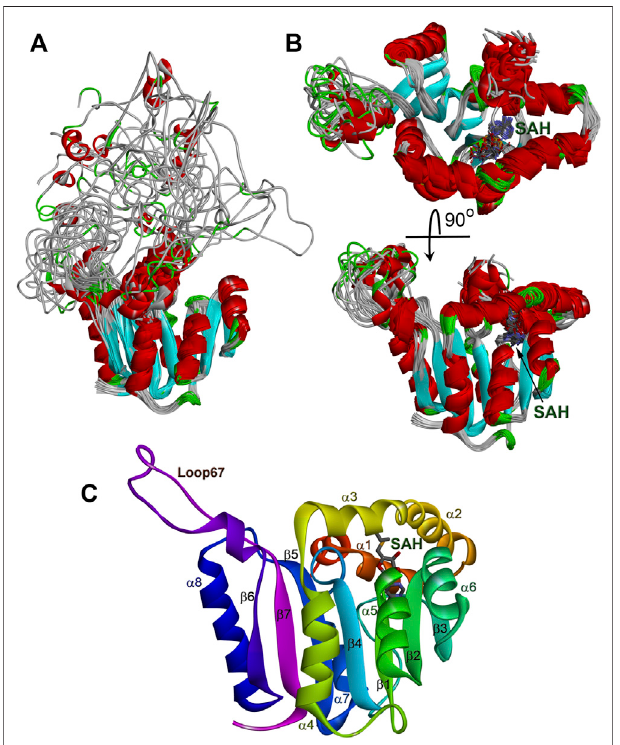
FIGURE3 | Structure ofWBSCR27 inapo-form (A) and in complex with SAH (B,C) . Families of 20 NMR conformers (A,B) and rainbow colored structure of WBSCR27-SAH complex with labelled elements of the protein structure are shown.